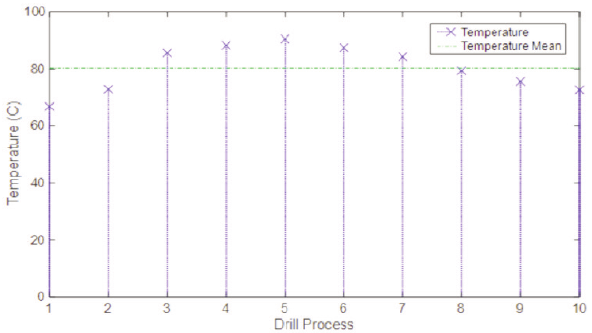
Temperature variation of the drill bit during drilling Fig. 6: measured with a thermal camera (Drill 1). Each temperature measurement was made as the drill process was finished for each hole before beginning the next